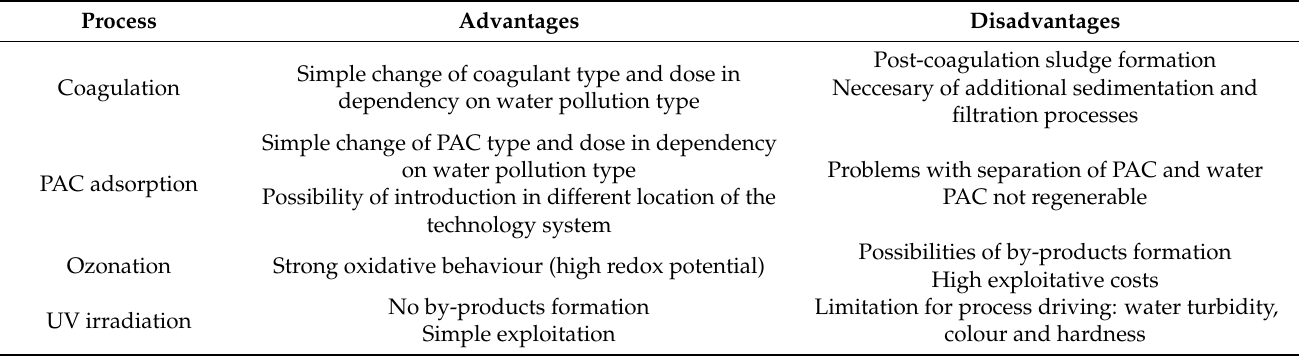
Table 1. Selected advantages and disadvantages of coagulation, PAC (powdered activated carbon) adsorption, ozonation and UV